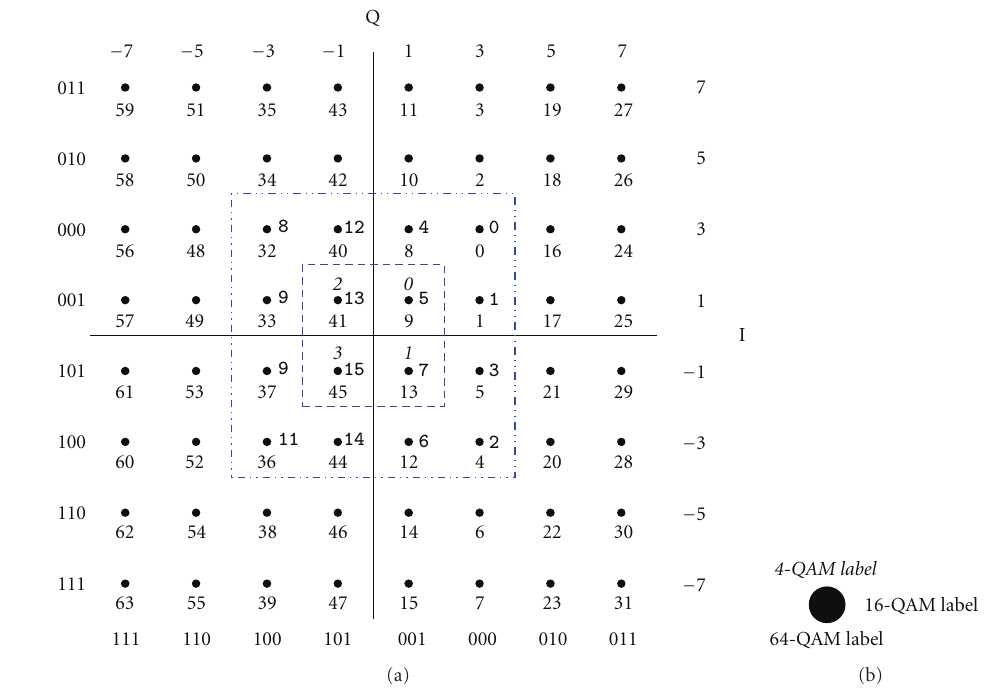
Figure 3: Digital architecture of the configurable ST/DDST transmitter.